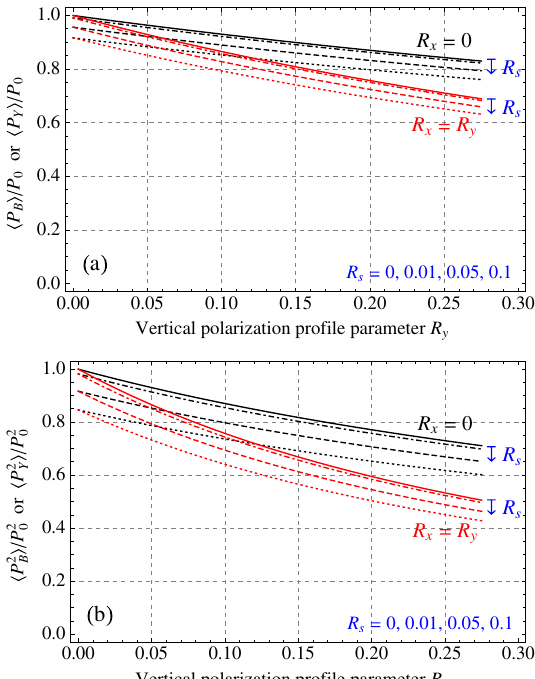
FIG. 1. (a) Relative reduction of the average polarization, P =P P =P FIG. 2. For single spin colliding beam experiments (a) relative B 0 or Y 0 , as a function of the vertical profile parameter R reduction of the average polarization h P B i =P 0 or h P Y i =P 0 , and y . (b) Ratio of the polarization measured by a polarimeter to the (b) relative reduction of the figure of merit h P 2 B i =P 2 0 or h P 2 Y i =P 2 0 , average polarization in single spin colliding beam experiments, P = h P i or P = h P i . The cases R ¼ 0 and R ¼ R as a function of the vertical profile parameter R y . The cases B B Y Y x x y are shown R ¼ 0 and R ¼ R R ¼ 0 ; 0 : 01 ; 0 : 05 ; 0 : 1 for R s ¼ 0 ; 0 : 01 ; 0 : 05 ; 0 : 1 each. x x y are shown for s